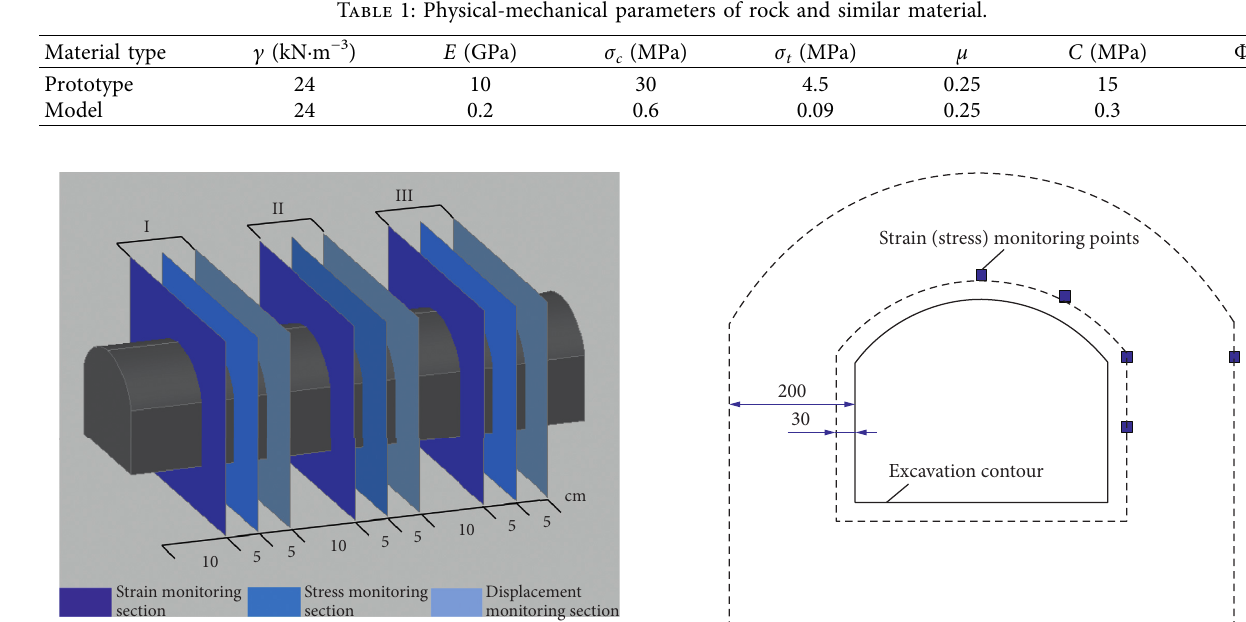
Figure 6: Monitoring section arrangement diagram.